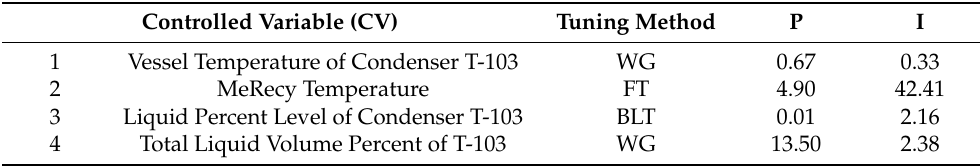
Table 15. Final controller parameter values.